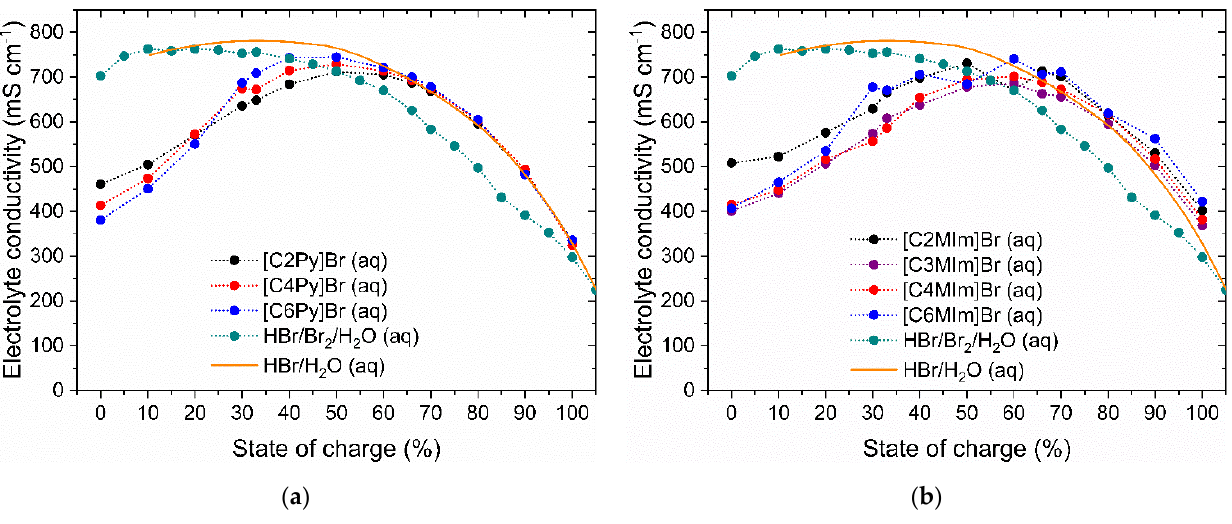
Figure 8. Specific electrolyte conductivity κ of the aqueous electrolyte phase containing ( a ) 1-alkylpyridin-1-ium bromides and ( b ) 1-alkyl-3-methylimidazol-1-ium bromides as BCAs with different alkyl side chains in the N-position as a function of state of charge SoC at θ = 23 ± 1 °C. In addition, electrolyte conductivities of BCA-free HBr/Br 2 /H 2 O electrolytes are shown (green dots) from [65] and of pure HBr/H 2 O solutions (orange line) from [66] at θ = 20 °C with the same total HBr and/or Br 2 concentrations as reference curves.